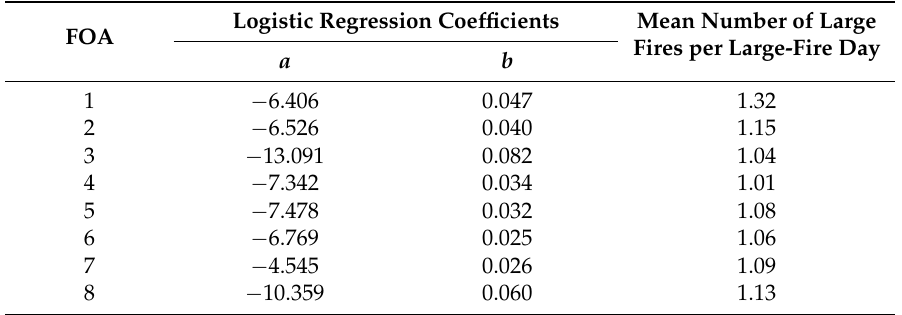
Table 5. Logistic regression coefficients and mean number of large fires per large-fire day, summarized by fire occurrence area (FOA).